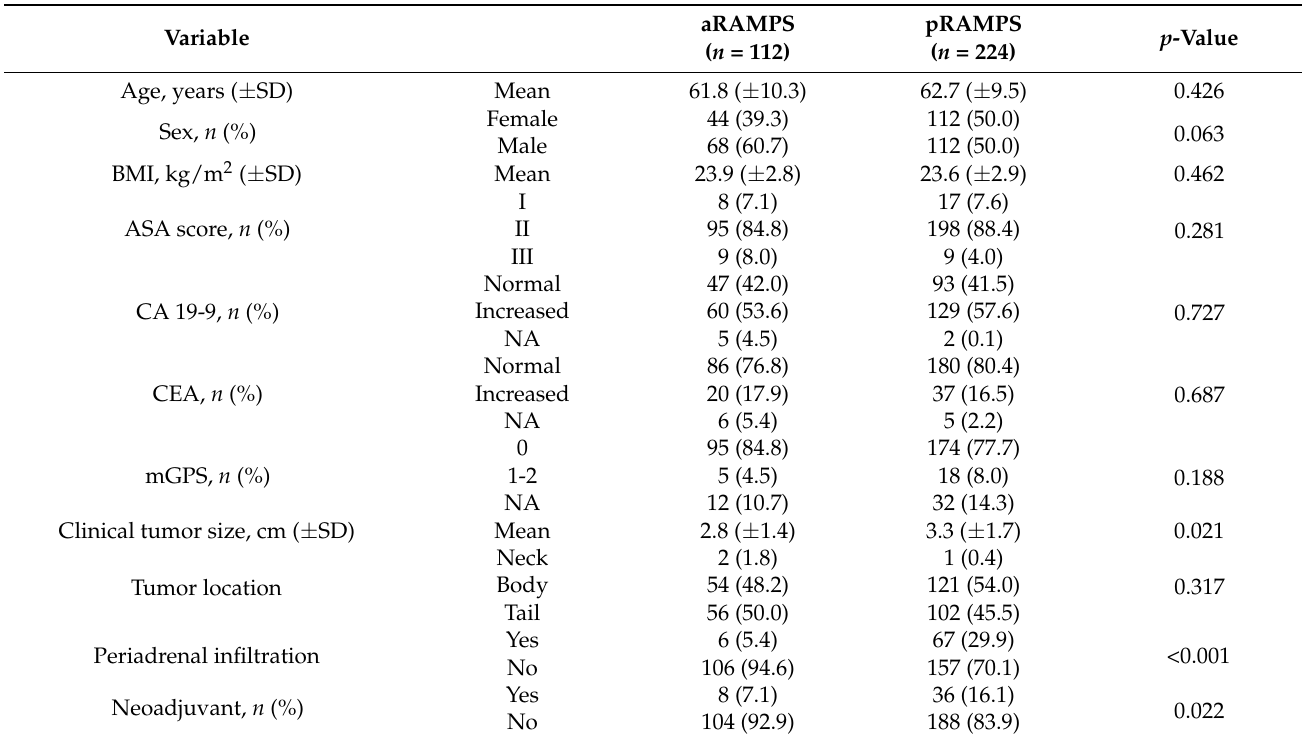
Table 1. Demographic and clinical characteristics of patients who underwent radical antegrade modular